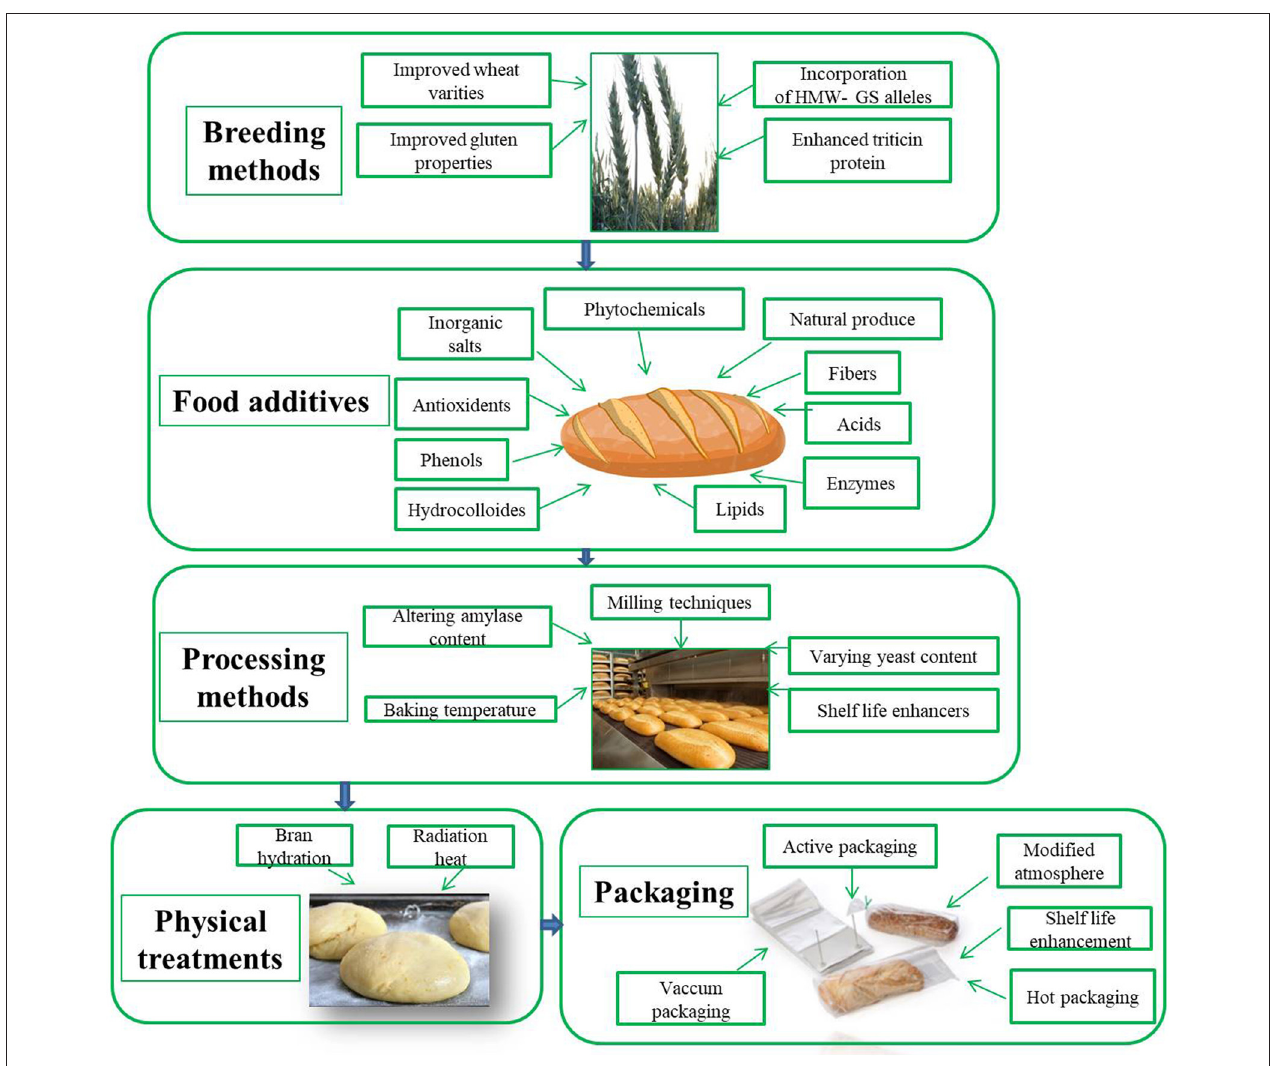
FIGURE 2 | Advancements in present day improving bread quality from breeding methods to processing